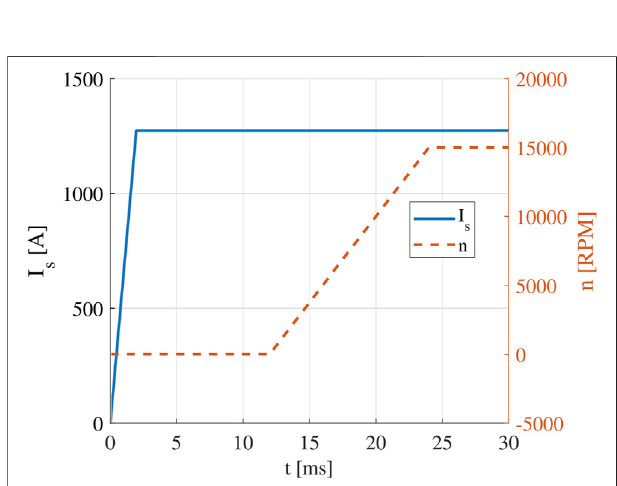
FIGURE 9 | I s and n waveform of the ramp function I s with the multistep ER method (FEA